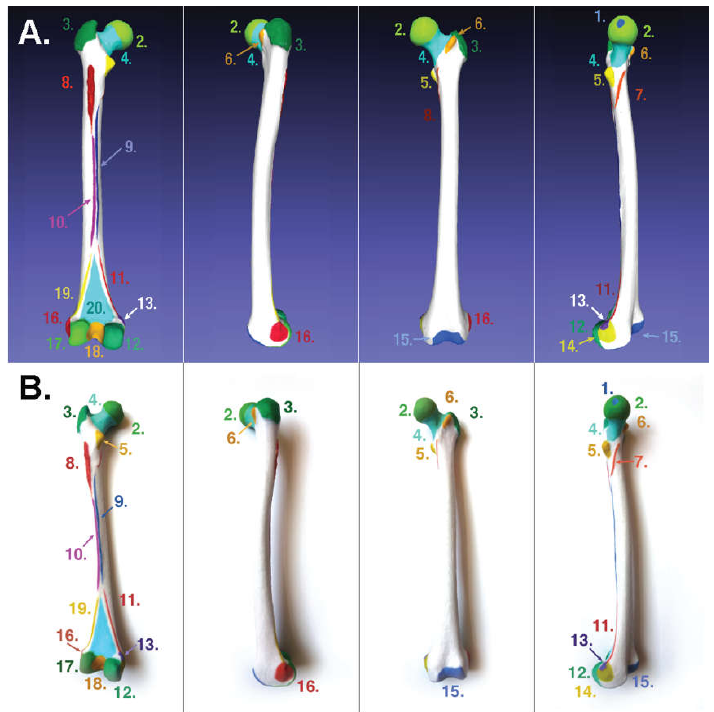
Figure 3. Panel A: Digital colored model (colored in Meshmixer, shown in Meshlab). Panel B: Resulting full‐color sandstone binder‐jet print of a femur featuring 1. fovea capitis, 2. head, 3. greater trochanter, 4. neck, 5. lesser trochanter, 6. trochanteric crest, 7. spiral line, 8. gluteal tuberosity, 9. medial lip of the linea aspera, 10. lateral lip of the linea aspera, 11. medial supracondylar ridge, 12. medial condyle, 13. adductor tubercle, 14. medial epicondyle, 15. patellar surface, 16. lateral epicondyle, 17. lateral condyle, 18. intercondylar fossa, 19. lateral supracondylar ridge, and 20. popliteal fossa. Image shows four views of the model starting with the dorsal view then rotating 90° to show all highlighted features.